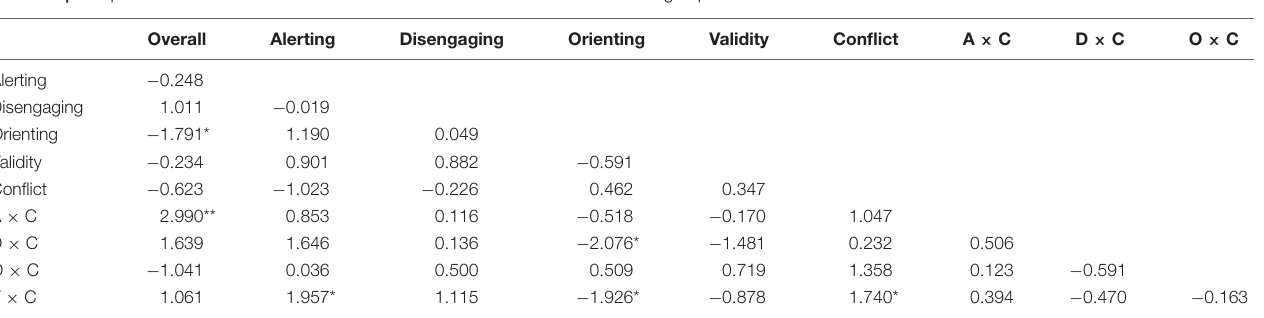
TABLE 4 | Comparison of the correlation coefficients for the attentional effects in different groups in the ANT-V.